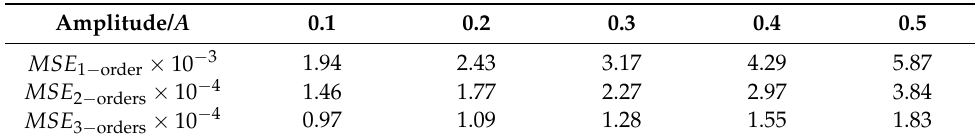
The sensitivity of KKF-VSM and RBF-NNM to regular undesired signals was com- pared. The results are shown in Figure 14. From it, it appears that when the amplitude of undesired signals was small, the ∆ MSE in KKF-VSM changed more obviously than that in RBF-NNM, but the result was the opposite when the amplitude became larger.